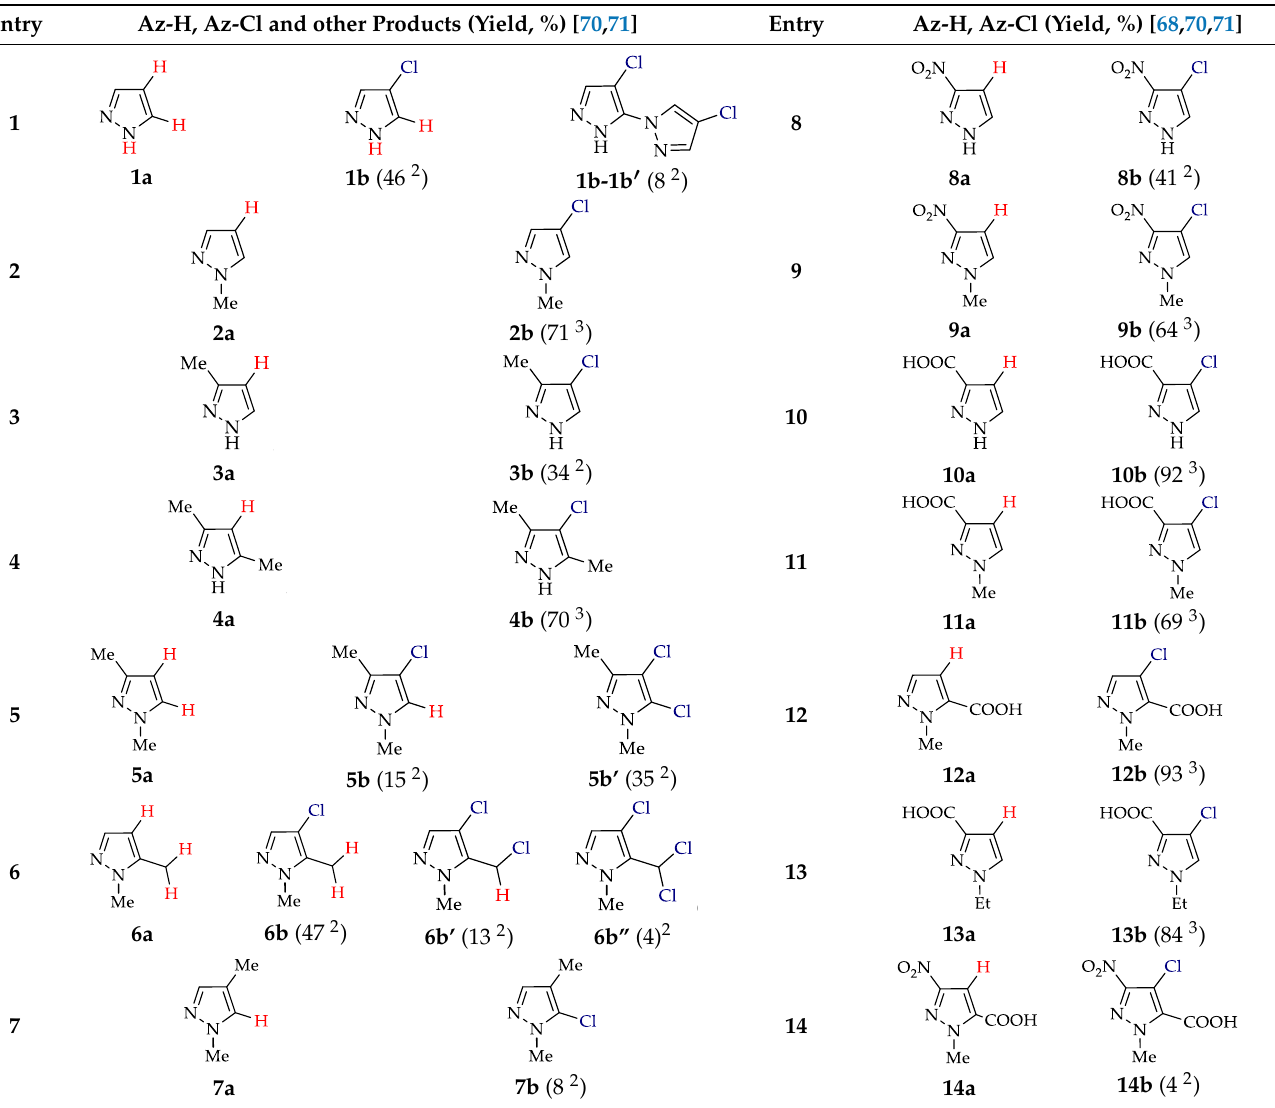
Table 1. C-H An chlorination of pyrazoles (Az-H) 1 . Table 1. C‒H An chlorination of pyrazoles (Az‒H) 1 . Table 1. C‒H An chlorination of pyrazoles (Az‒H) 1 . Table 1. C‒H An chlorination of pyrazoles (Az‒H) 1 . Table 1. C‒H An chlorination of pyrazoles (Az‒H) 1 . Table 1. C‒H An chlorination of pyrazoles (Az‒H) 1 . Table 1. C‒H An chlorination of pyrazoles (Az‒H) 1 . Table 1. C‒H An chlorination of pyrazoles (Az‒H) 1 . Table 1. C‒H An chlorination of pyrazoles (Az‒H) 1 . Table 1. C‒H An chlorination of pyrazoles (Az‒H) 1 . Table 1. C‒H An chlorination of pyrazoles (Az‒H) 1 . Table 1. C‒H An chlorination of pyrazoles (Az‒H) 1 . Table 1. C‒H An chlorination of pyrazoles (Az‒H) 1 . Table 1. C‒H An chlorination of pyrazoles (Az‒H) 1 . Table 1. C‒H An chlorination of pyrazoles (Az‒H) 1 . Table 1. C‒H An chlorination of pyrazoles (Az‒H) 1 . Table 1. C‒H An chlorination of pyrazoles (Az‒H) 1 . Table 1. C‒H An chlorination of pyrazoles (Az‒H) 1 . Table 1. C‒H An chlorination of pyrazoles (Az‒H) 1 . Table 1. C‒H An chlorination of pyrazoles (Az‒H) 1 . Table 1. C‒H An chlorination of pyrazoles (Az‒H) 1 . Table 1. C‒H An chlorination of pyrazoles (Az‒H) 1 . Table 1. C‒H An chlorination of pyrazoles (Az‒H) 1 . Table 1. C‒H An chlorination of pyrazoles (Az‒H) 1 . Table 1. C‒H An chlorination of pyrazoles (Az‒H) 1 . Table 1. C‒H An chlorination of pyrazoles (Az‒H) 1 . Table 1. C‒H An chlorination of pyrazoles (Az‒H) 1 . Table 1. C‒H An chlorination of pyrazoles (Az‒H) 1 . Table 1. C‒H An chlorination of pyrazoles (Az‒H) 1 . Table 1. C‒H An chlorination of pyrazoles (Az‒H) 1 . Table 1. C‒H An chlorination of pyrazoles (Az‒H) 1 .